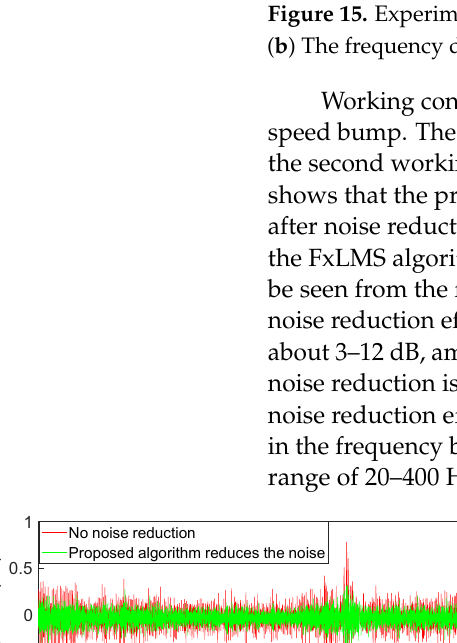
Figure 15. Experimental effect of noise reduction at a 40 km/h constant speed. ( a ) The time domain, ( b ) The frequency domain.